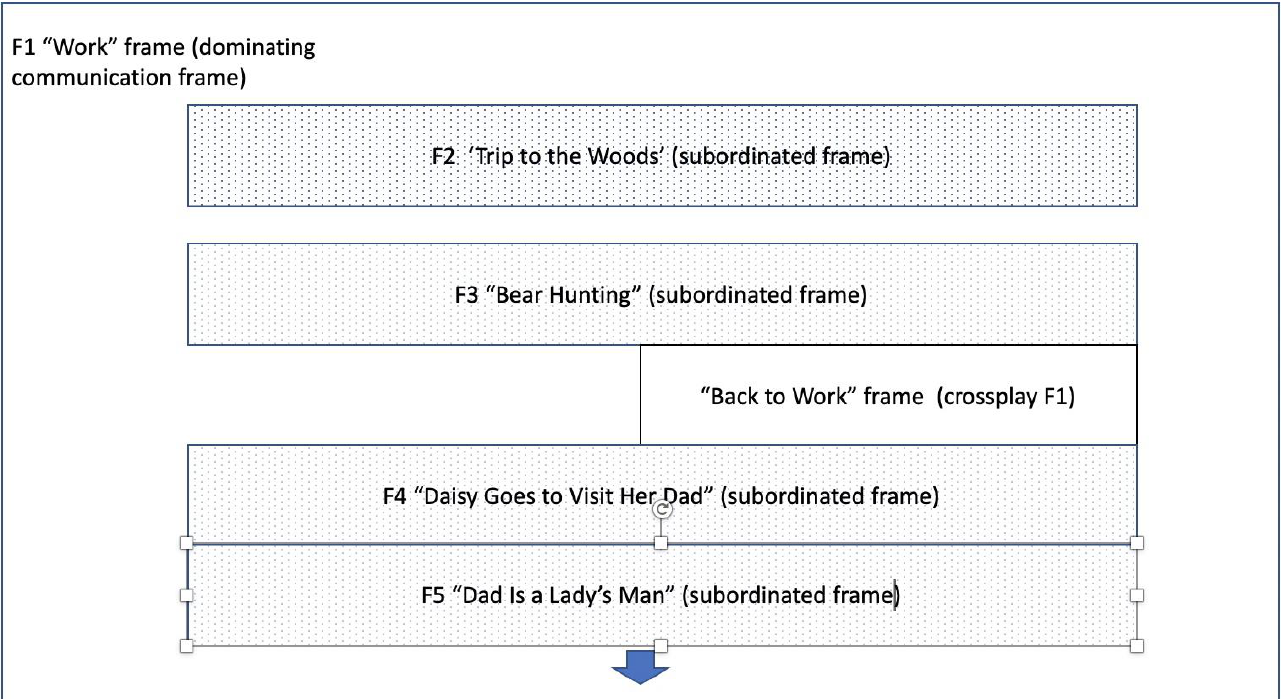
Figure 1. Framing construction schemata.